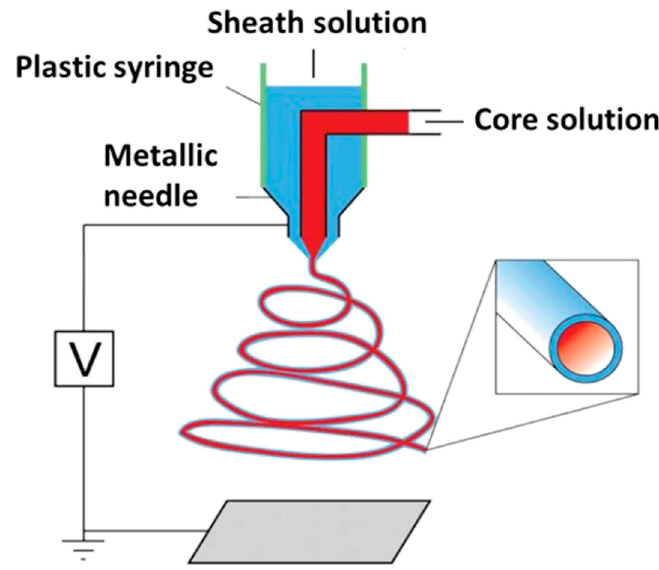
Figure 9. Schematic representation of an electrospinning set-up used for coaxial electrospinning— reproduced with permission from [131]. Copyright American Chemical Society,